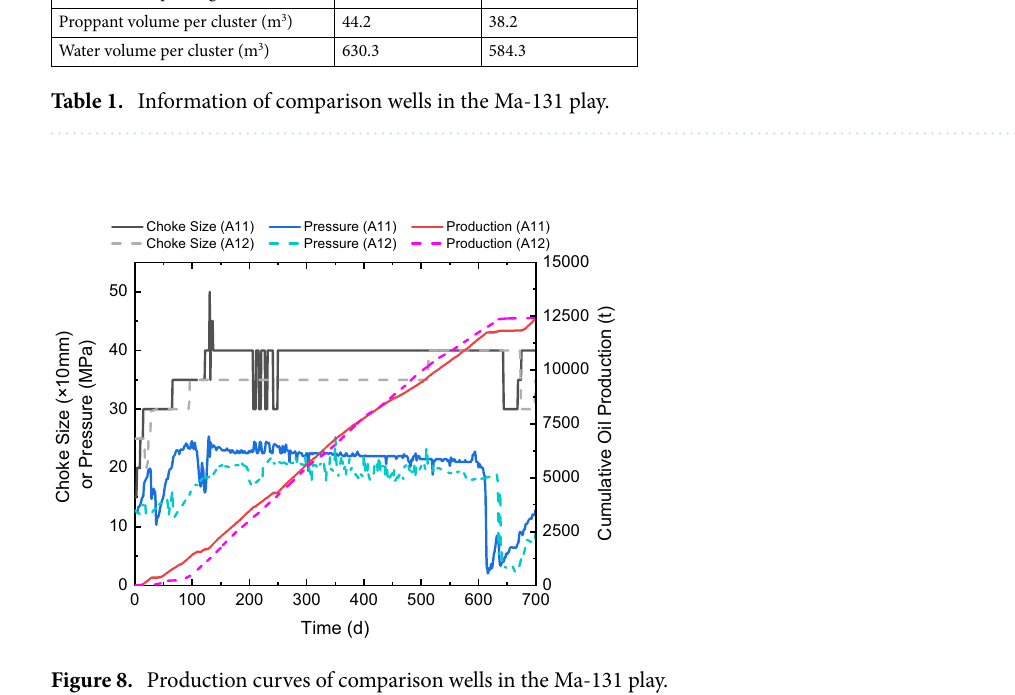
Figure 8. Production curves of comparison wells in the Ma-131